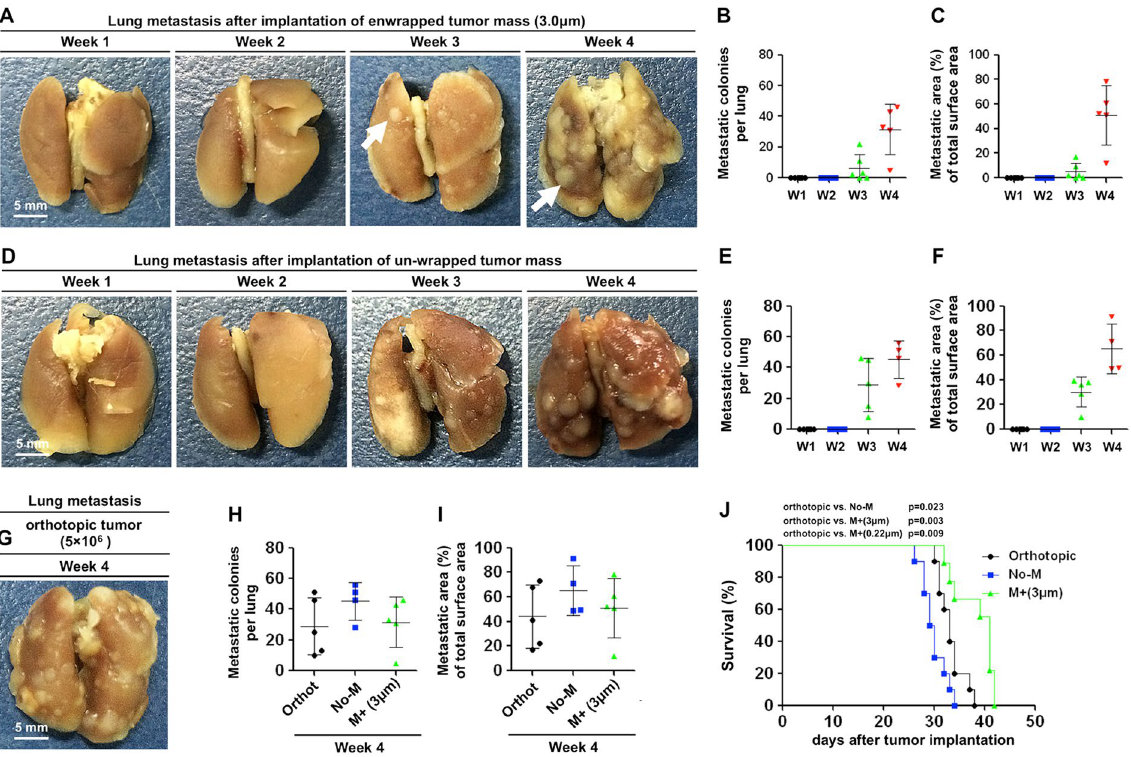
Figure 4. Cutting off tumor blood supply could not prevent the formation of distant metastases. ( A , D ) After implantation of a 3.0 μ m membrane-wrapped tumor or an un-wrapped tumor for 1, 2, 3, and 4 weeks, the lungs of the tumor-bearing mice were harvested and fixed with 4% paraformaldehyde (PFA) to observe the formation of lung metastases. ( B,E ) The number of tumor colonies on the surface of the lung was counted. ( C,F ) The metastatic lesions were quantified as the percentage of metastatic areas per lung area. The data are presented as scatter plots with means ± SD. The number of dots indicates the “n” of each group. ( G ) Lung metastases from the primary orthotopic breast tumor. ( H,I ) Comparison of the metastatic colonies and metastatic area of the lung surface. Orthot: the orthotopic mammary 4T1 tumor; No-M: the implantation of an un-wrapped tumor mass; M + 3.0 μ m: the implantation of a tumor mass wrapped with a 3.0 μ m membrane. ( J ) The Kaplan-Meier survival analysis of the mice bearing an orthotopic tumor or implanted tumor (n = 10 per group). The data were analyzed using a log-rank test. The p values are shown within the